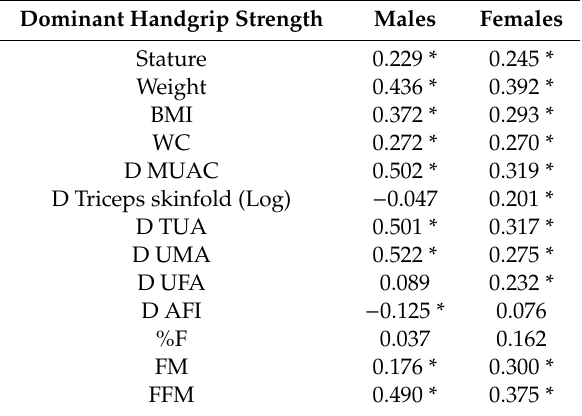
Table 6. Pearson correlation coe ffi cients between anthropometric variables and dominant handgrip strength by sex (asterisks denote statistical significance at the p < 0.05 level; D = dominant side). Dominant Handgrip Strength Males Females Stature 0.229